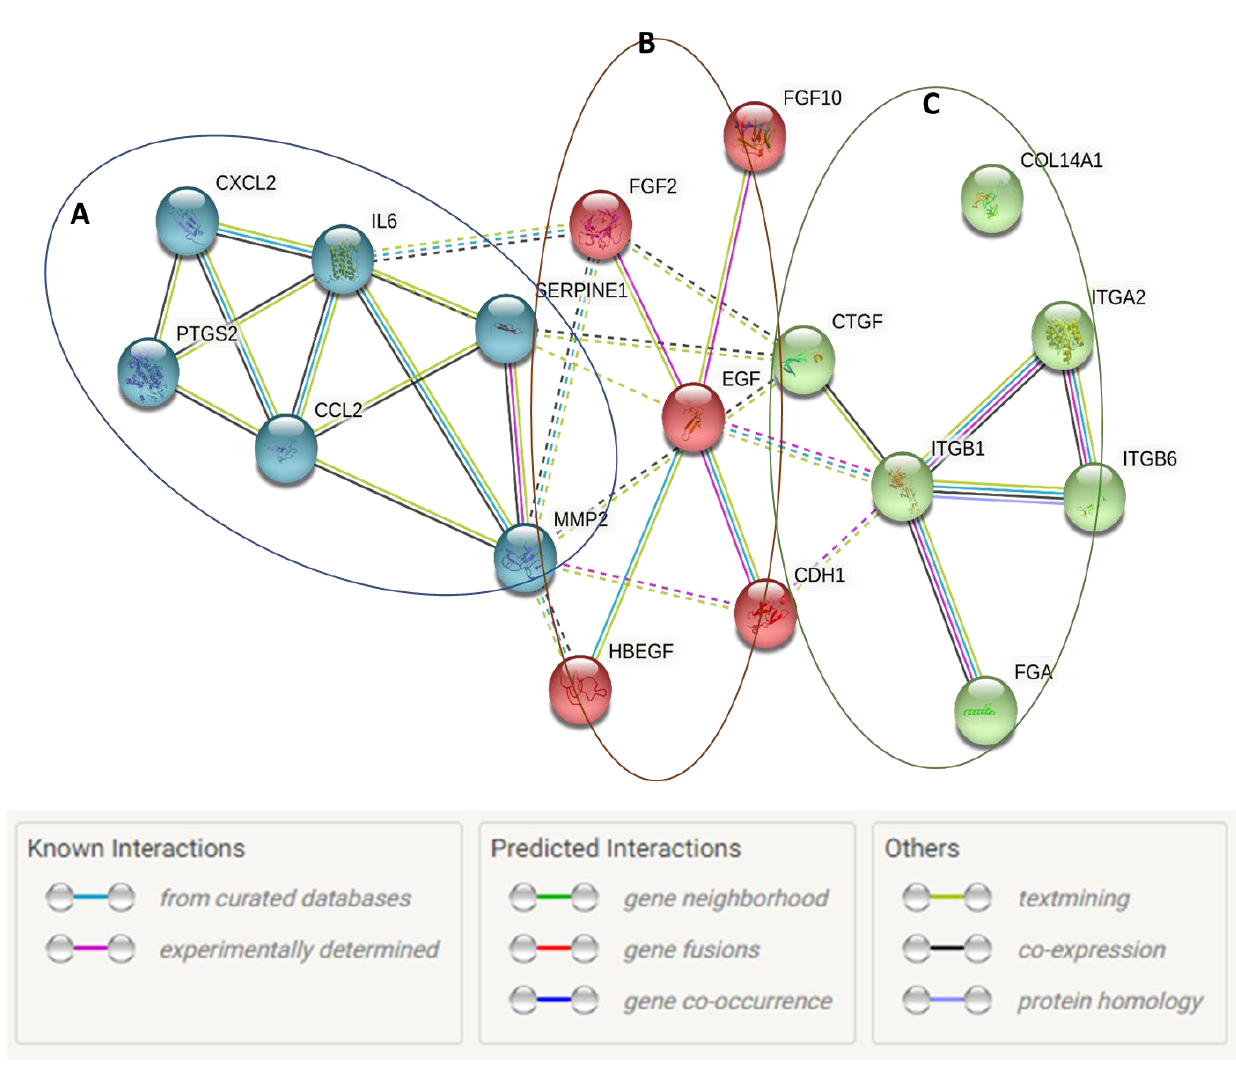
Figure 6. Protein networks showing the interactions between DEGs in the Cotyledon -AgNPs treated KMST-6 cells. These networks were determined using the STRING database. Table 2. Enriched pathways in which the Cotyledon -AgNPs expressed DEGs function through.